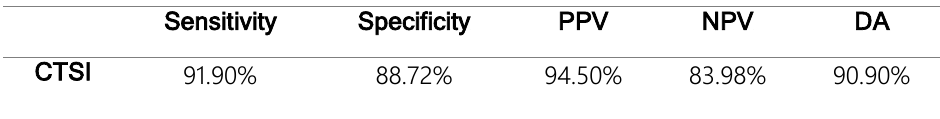
Table 1: Sensitivity, specificity and diagnostic accuracy of CTSI for detection in predicting outcomes in